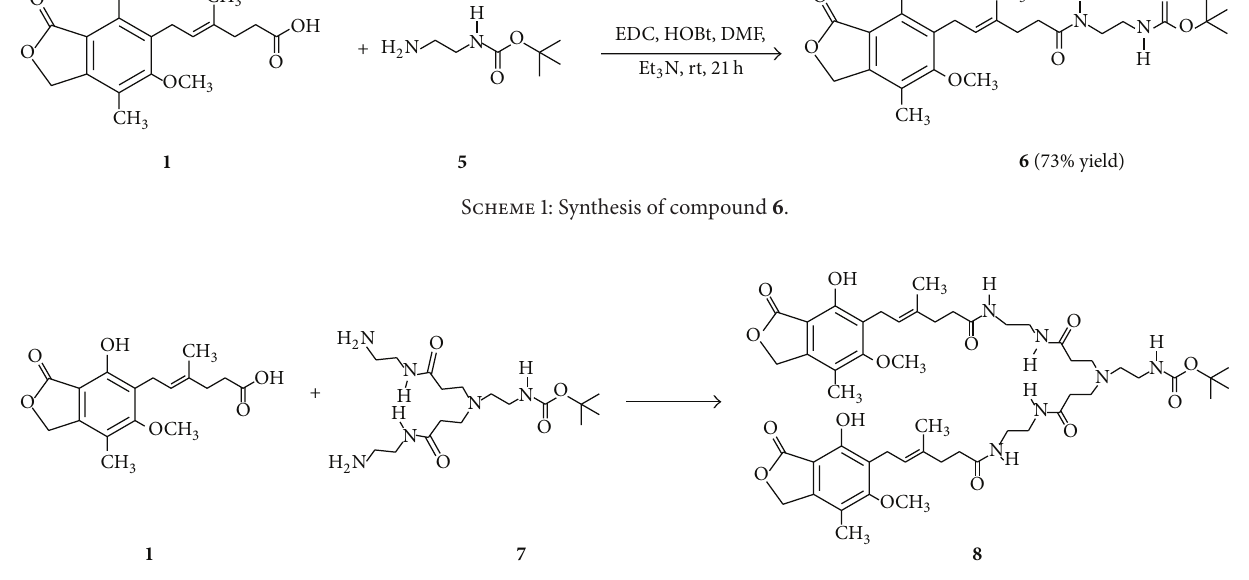
Scheme 2: Synthesis of compound 8 . Reaction conditions: EDC, DMPA, DMF, room temperature, 48h (76% yield) or EDC, HOBt, DMF, Et 3 N, room temperature, 48 h (57%